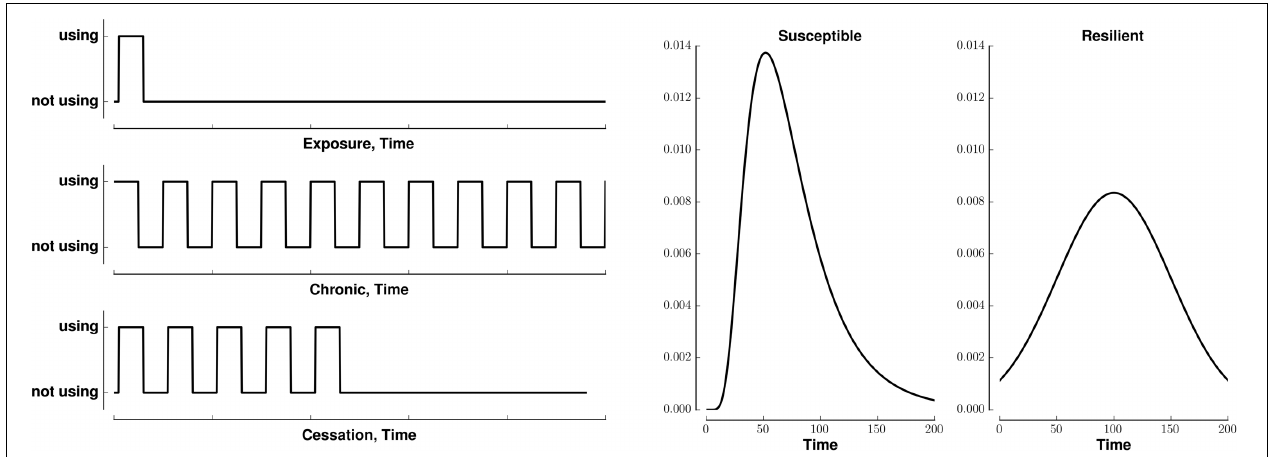
FIGURE 1 | Patternsofstimuli and rewards used asinput. Left: Templates forthree different patterns of binarystimuli,isolated(exposure), tonic (chronic), and cessation. Right: Templatesfortwodifferentdynamicsofrewardsalience,log-Gaussian(susceptible)andGaussian(resilient).Alltemplateslastfor200timesteps.